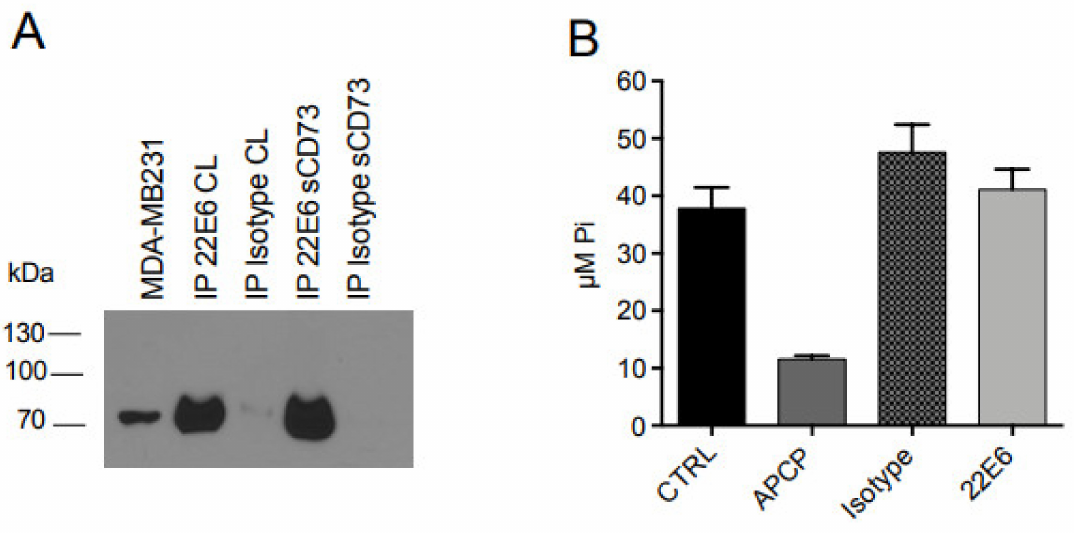
Figure 5. 22E6 does not inhibit enzyme activity of soluble CD73. ( A ) specific precipitation of recombinant CD73 by 22E6. ( B ) 22E6 does not detectably inhibit enzyme activity of soluble CD73. Error bars = SD; p < 0.001 for APCP, n.s. for Isotype and 22E6. This experiment was performed at least four